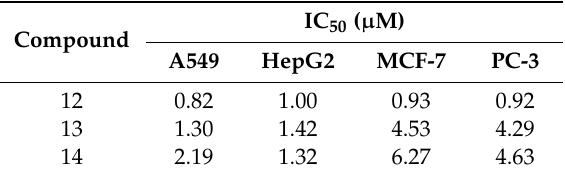
Table 4. Inhibition of cells by compounds 12 , 13 and 14.